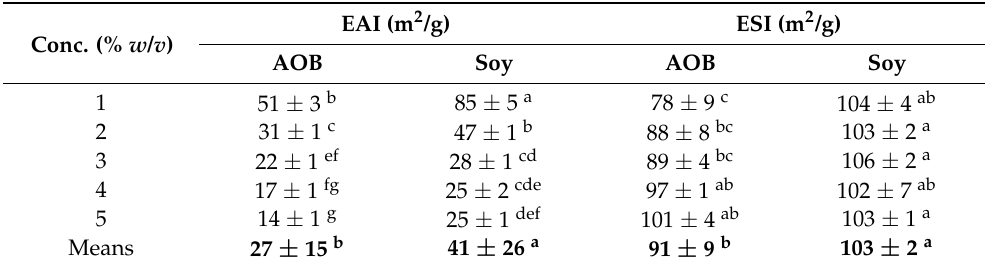
Table 5. Emulsifying ability index (EAI) m 2 /g and emulsifying stability index (ESI) (%) of commercial soy and AOB seeds protein